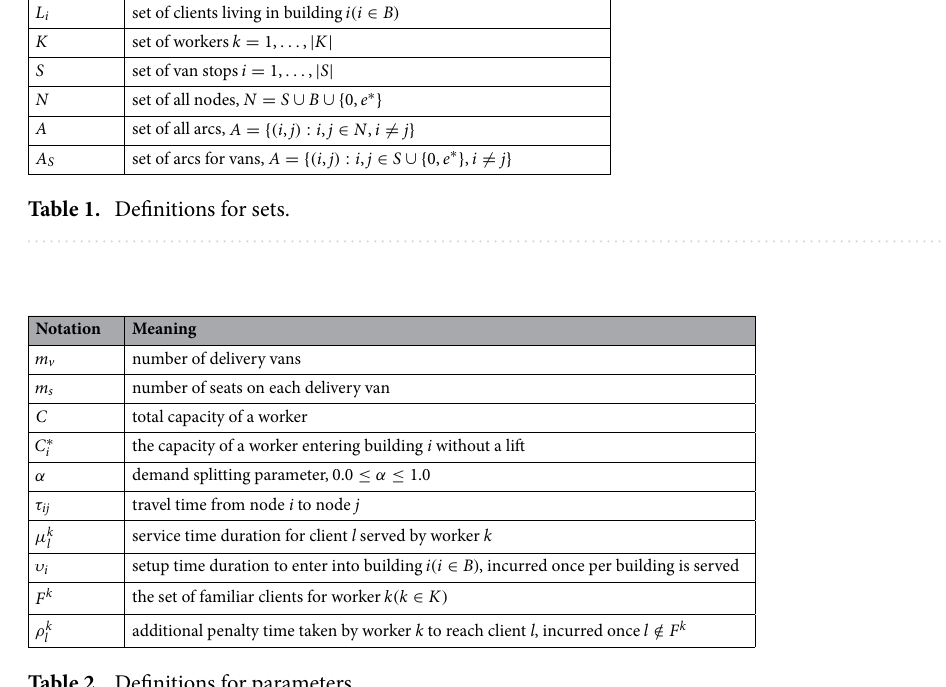
Table 2. Definitions for